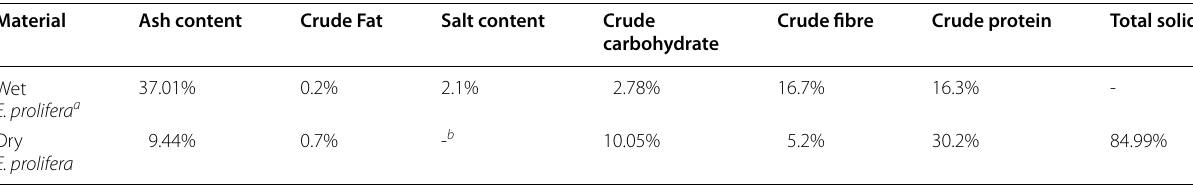
a The wet E. prolifera was dried in 65 °C for 24 h before measured. b not detected